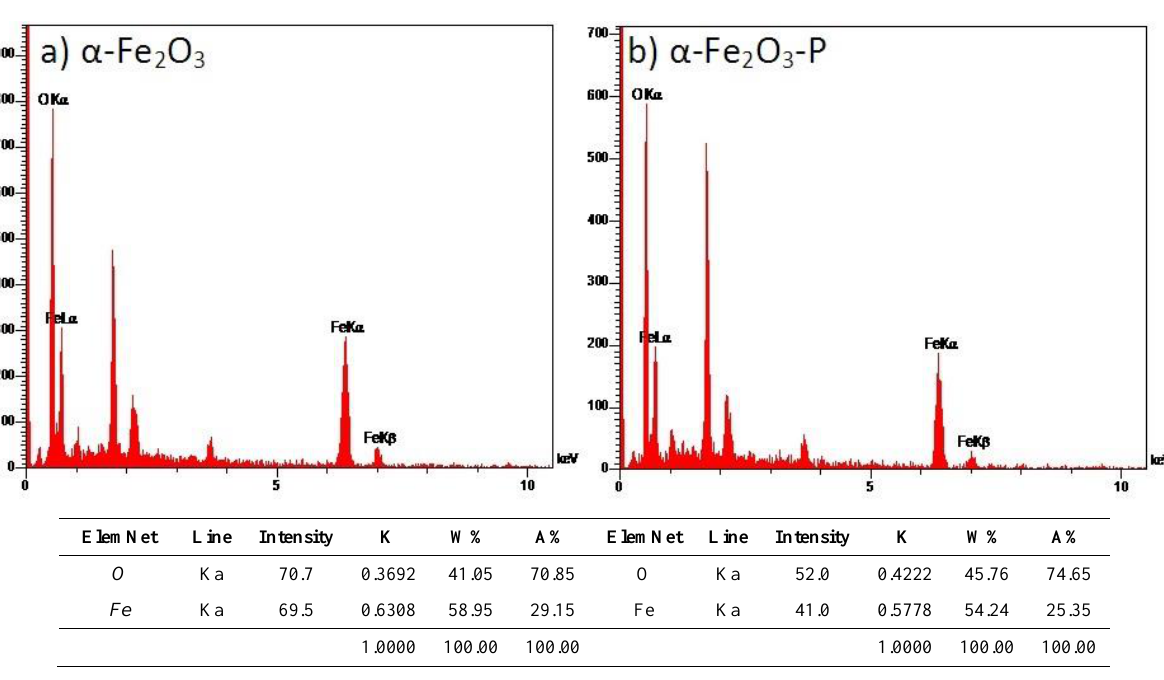
Figure 4. EDX Image of α-Fe 2 O 3 Thin Films, (a) prior to the plasma application and (b) following the plasma application 3-3- AFM